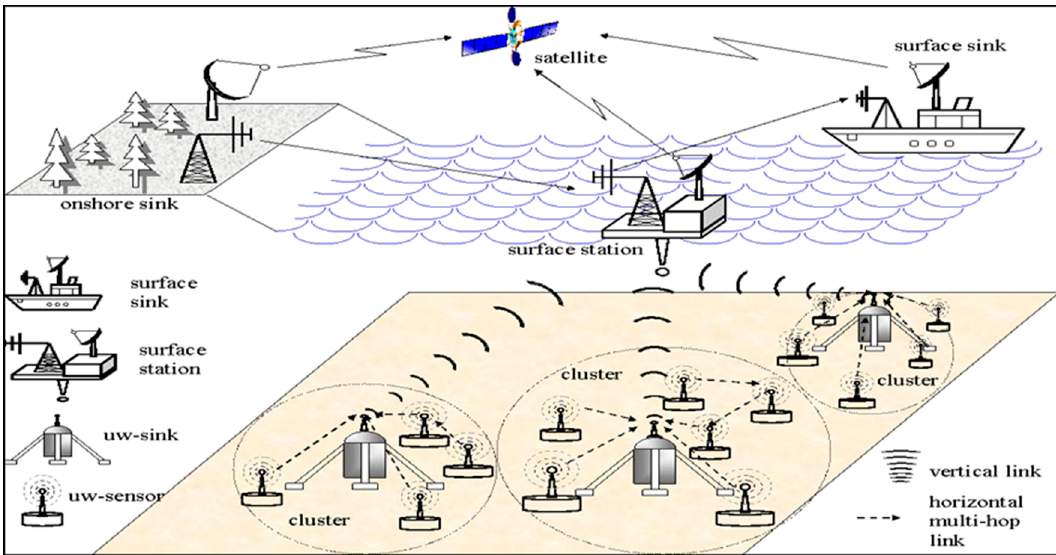
Figure 1. Cluster-based architecture of UASNs.